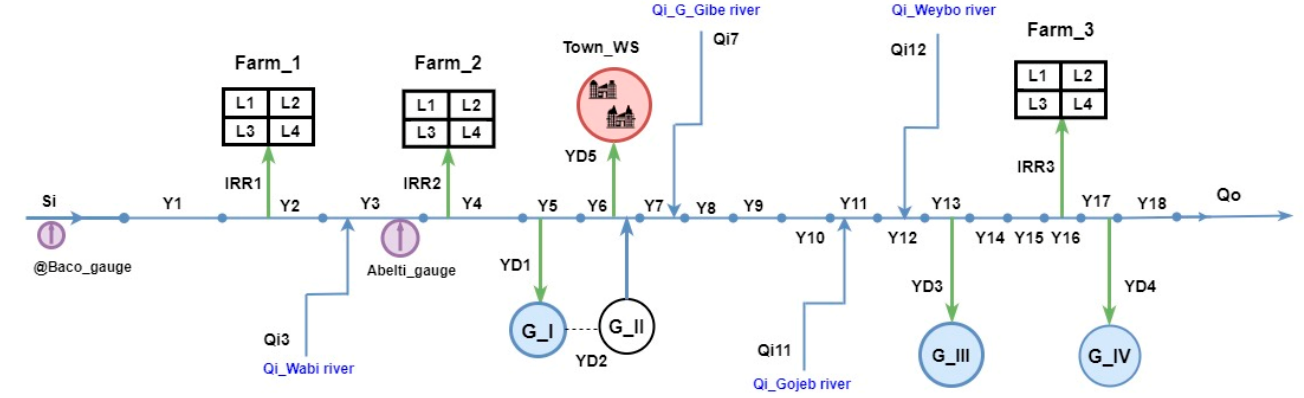
Figure 9. Diagram of the land and river network (it has 3 farms (F1(IRR1), F2(IRR2), F3(IRR3), 4 land units (L1…L4), and 18 river segments (Y1…Y18), 4 hydropower stations/demand nodes (YD1…YD4) and 1 water supply demand node (YD5). The gauge stations are near Baco town (supply inflow) and Abelti (around the main bridge on the main road to Jimma are indicated on the diagram. Objective functions and